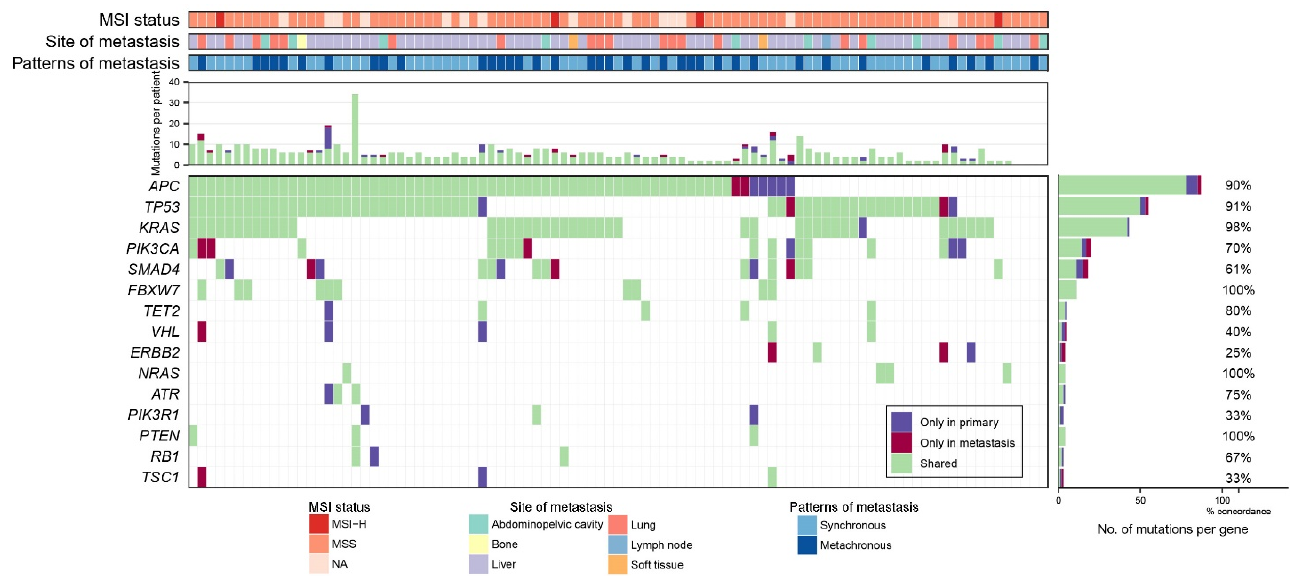
Figure 1. Overview of mutational profile of 95 pairs of primary-metastatic colorectal cancers. Each column represents a patient. The top 4 panels show MSI status, site of metastasis, patterns of metastasis and number of variant counts per patients. The bottom panel show mutational status, shared, only in primary and only in metastasis. When there are 2 or more mutation type presents, (i.e., ‘shared’ and ‘primary only’) ‘shared’ is preferentially used. The right panel represents the number of patients with variants as bar graph and concordance of the variants as percentage of corresponding genes.